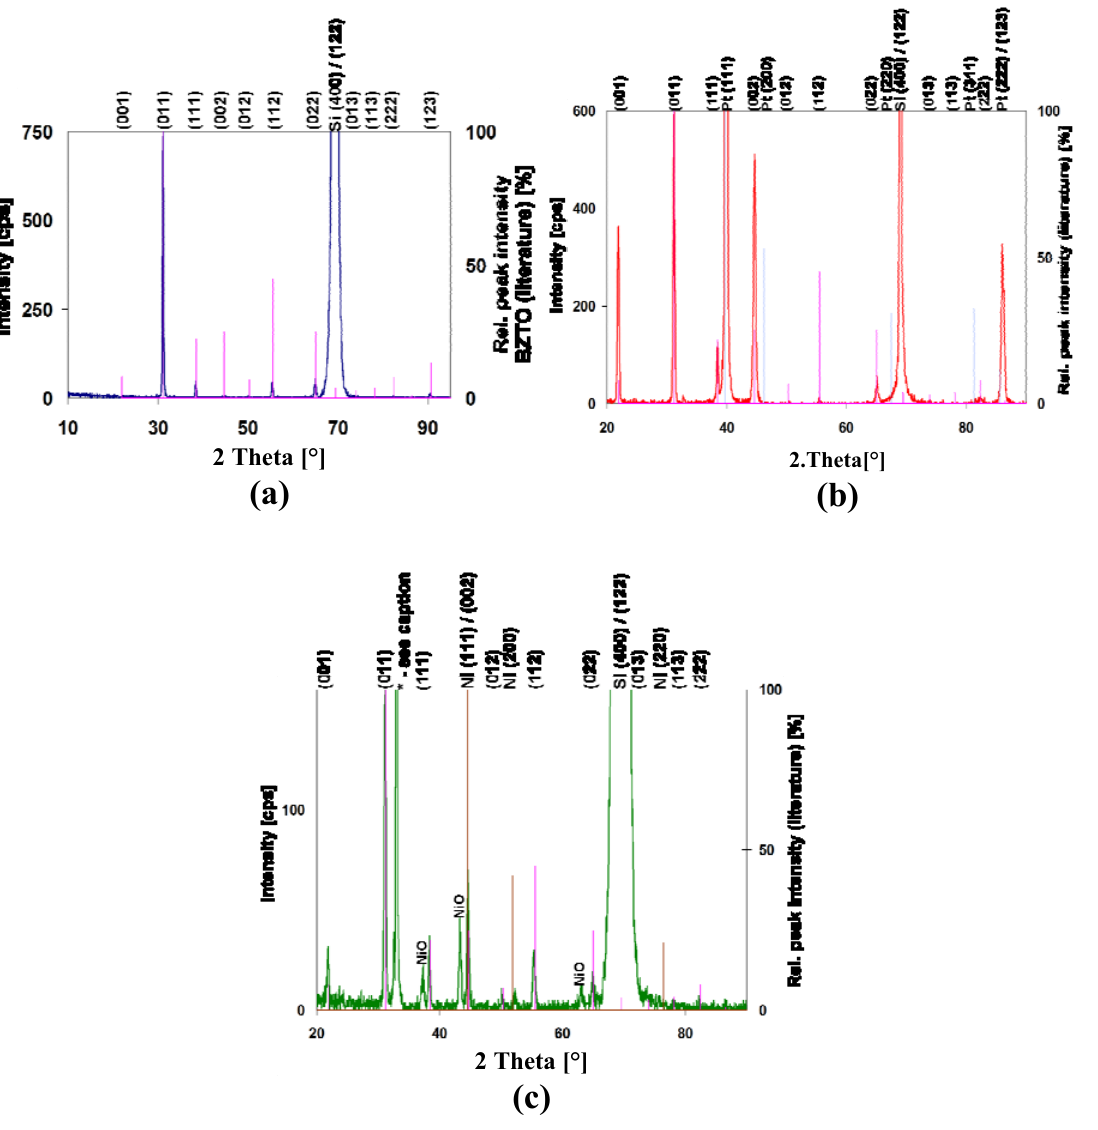
Figure 5. θ –2 θ XRD pattern (Cu K α radiation) of BCZTO films deposited at 900 °C, 10 mtorr pressure, 10% O in Ar onto: (a) a bare (100) Si wafer; (b) a Pt bottom electrode 2 structure; (c) a Ni bottom electrode structure. Peak intensities are normalized to the BCZTO (011) peaks at 100% relative intensity. Also shown for reference are the peak positions and relative intensities of barium zirconate-titanate, Pt and Ni taken from the powder diffraction database [27–29]